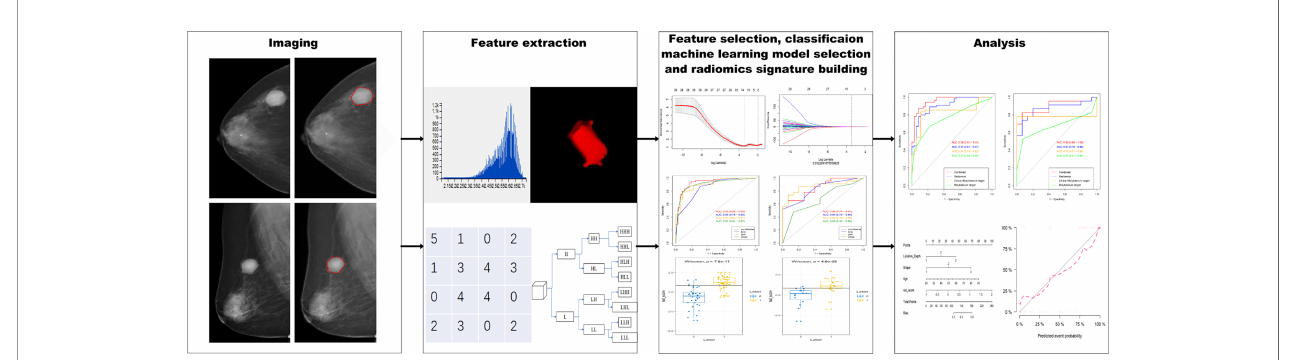
FIGURE 1 | Flow chart of radiomic analysis of round-like masses on